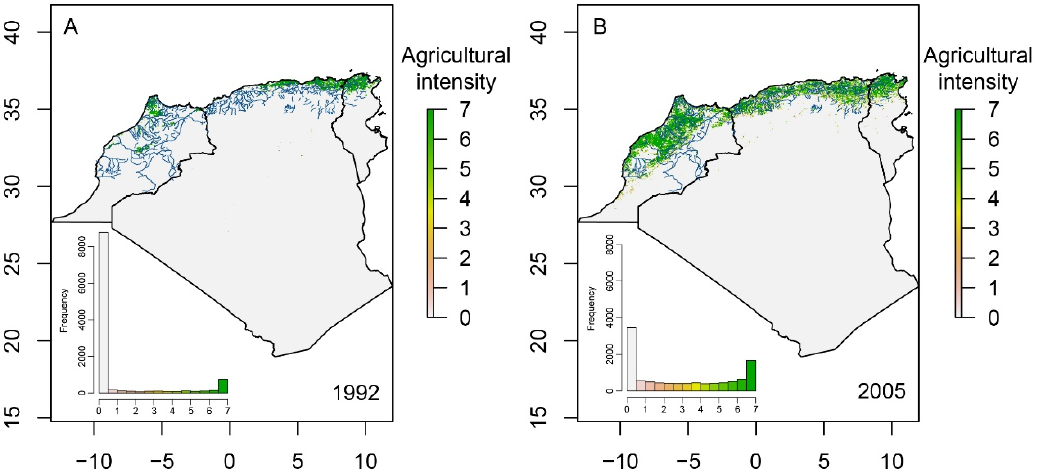
Figure 4. Change in the extent and intensity of the agriculture in North Africa from 1992 ( A ) to 2005 ( B ). The agricultural intensity ranges from 0 to 7 where 0 indicates the absence of agricultural activity and 7 indicates intense practices [47]. The main watercourses of the region are displayed in blue. The histogram shows the frequency distribution of agricultural intensity around the main watercourses (2 km buffer). Note the abrupt decline in the frequency of low agricultural intensity and the increase in the frequency of the other intensities from 1992 to 2005.